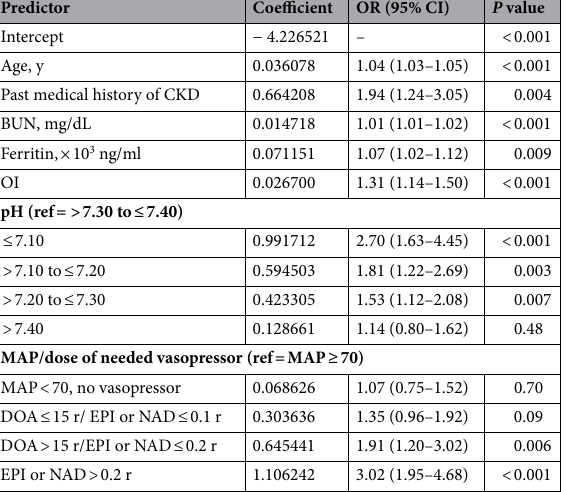
Table 2. Pooled results of multivariable logistic regressions over 33 imputed datasets. y, years; CKD, chronic kidney disease; BUN, blood urea nitrogen; OI, oxygen index; Ref, reference level; OR, odds ratio; CI, confidence interval; MAP, mean arterial pressure; r, mg/kg/min; DOA, dopamine; EPI, epinephrine; NAD,